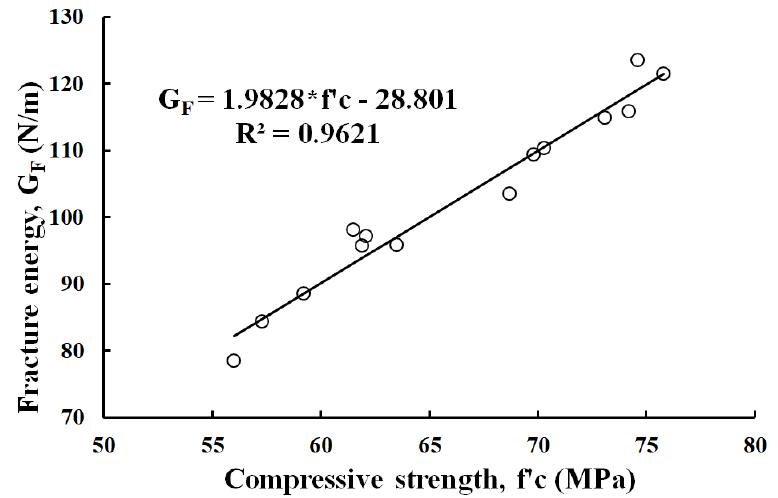
Figure 6. Fracture energy versus compressive strength of fly ash concrete.